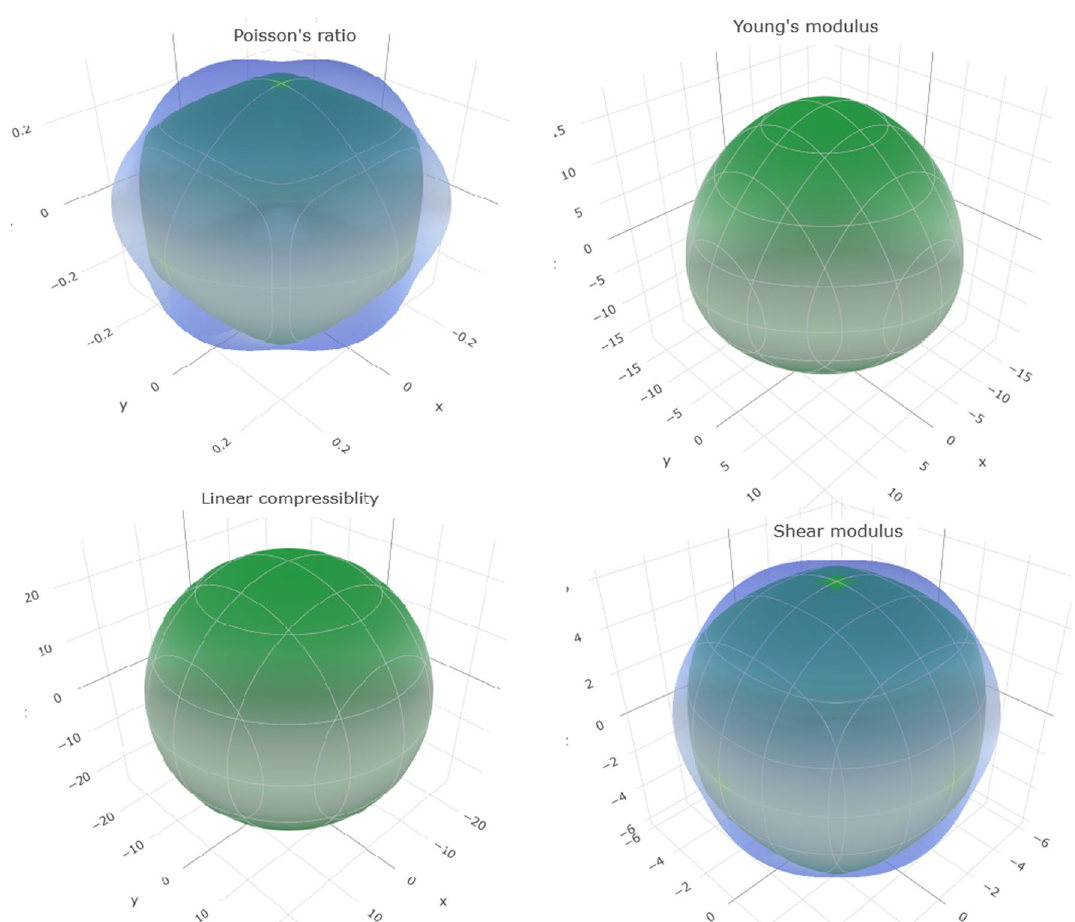
Figure 6. The orientation effect on Poisson’s ratio, Young’s modulus, linear compressibility and shear modulus in